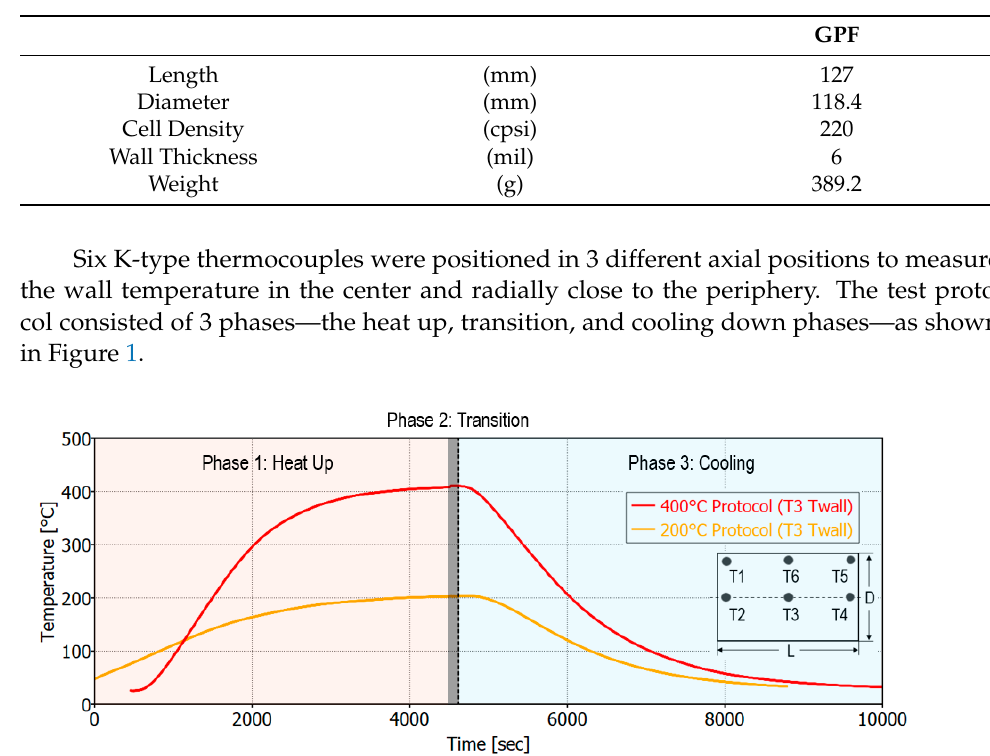
Table 1. Properties of the testing monolith.